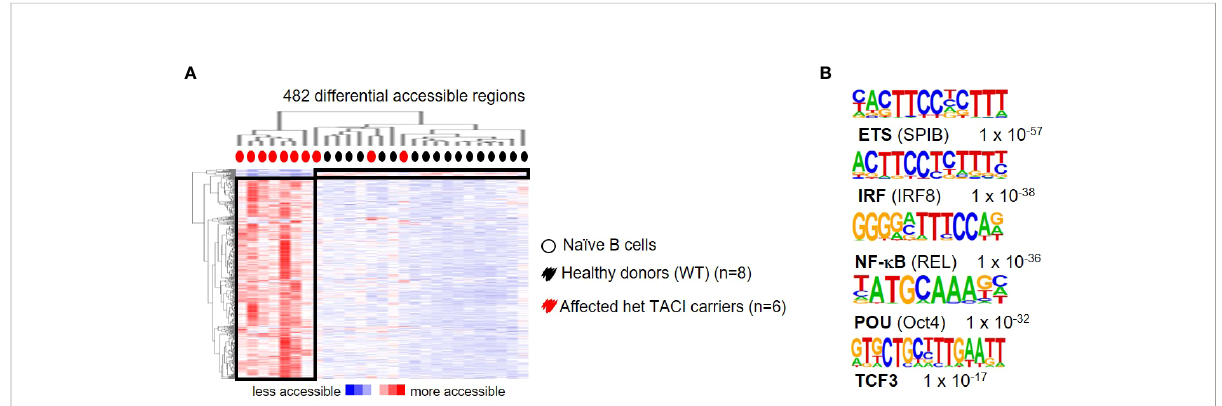
FIGURE 6 Dysregulated chromatin landscape in stimulated naïve B cells from TACI mutation carriers. (A) Heatmap including hierarchical clustering of 482 differentially accessible chromatin regions in TACI mutation carriers compared to WT. Preferentially open regions amounted to 465 in TACI mutation carriers and 17 in WT. (B) Cis-regulatory sequences associated with regions of the TACI mutation carriers. Transcription factor family stated fi rst and in brackets the family member. Genes were normalized and centered with Cluster 3.0 and visualized with Java Treeview with color indicating the region with maximum (red) or minimum (blue) open chromatin. Sequence logos and p -values re fl ecting the signi fi cance of motif occurrence are shown next to the corresponding